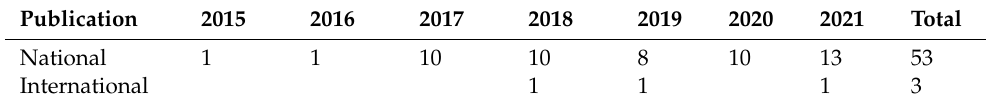
Table 7. S university’s publication of journal papers on